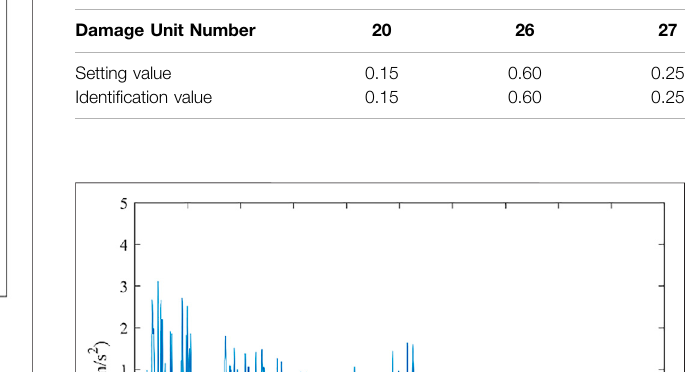
TABLE8| Identi fi cationvaluesandsettingvaluesofunitdamagedegreesoftruss.